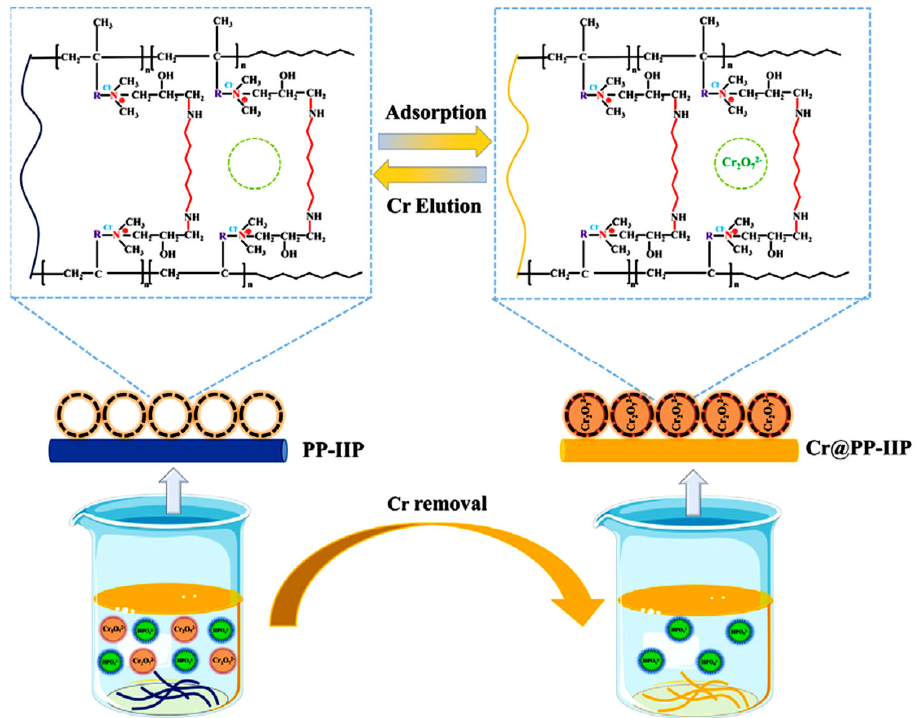
Figure 14. Schematic illustration of the action of PP ‐ IIP in the removal of Cr(VI). Green circle represents Cr 2 O 72 − anions (reproduced with permission from Ref. [144]. Copyright 2021 Elsevier).